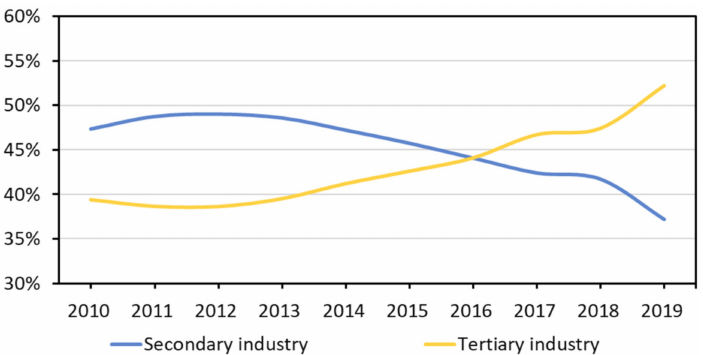
Figure 7. Proportion of GDP of the second and tertiary industries in Southwest